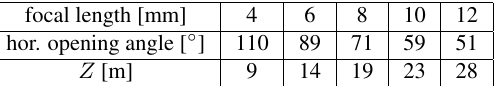
Table 1. Maximum distance (Z) to project a person of 1.75m into image space, having the same height as person images in the most cited PRID dataset VIPeR (128